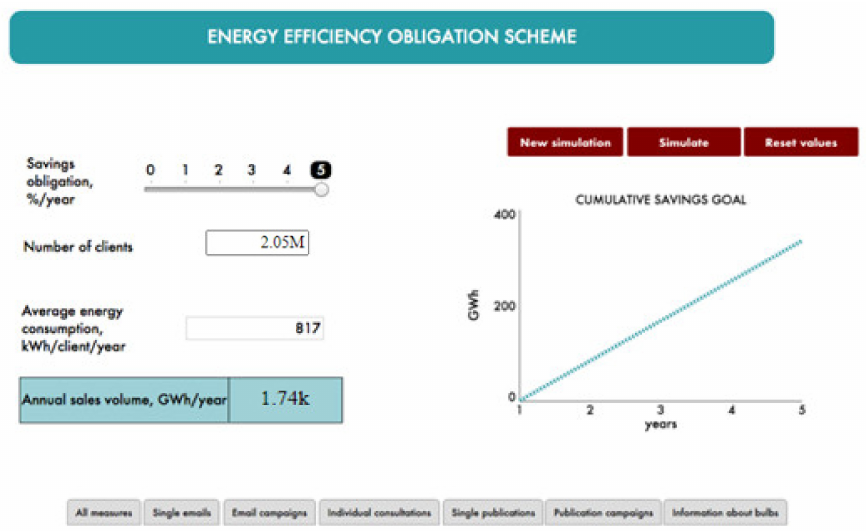
Figure 6. The main page of the free access Internet-based interface